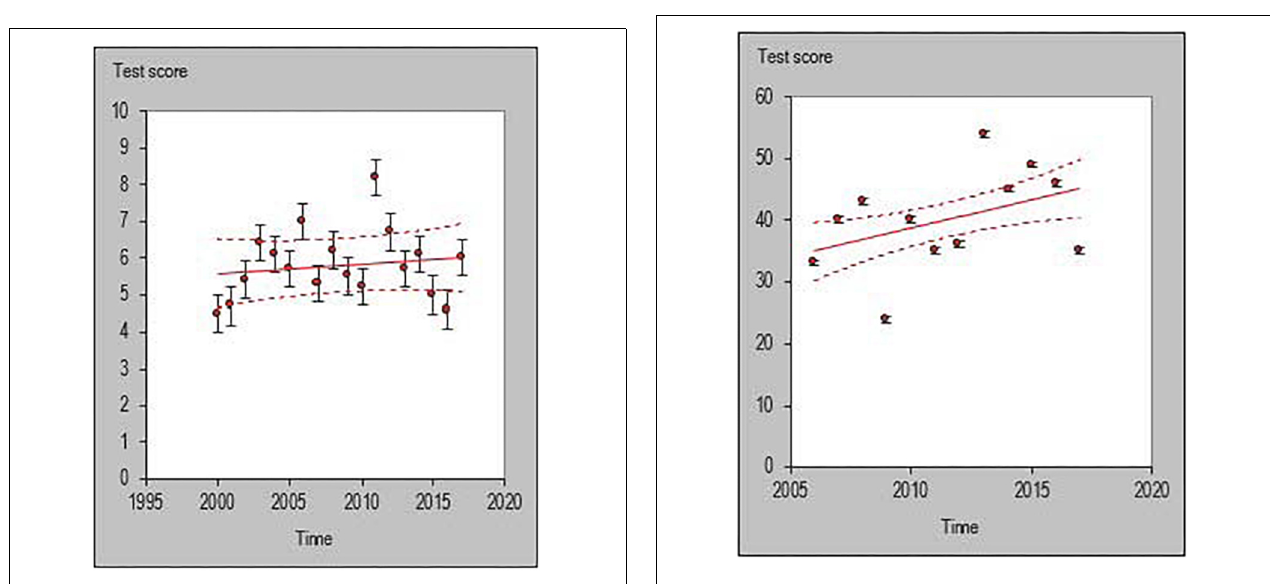
FIGURE 4 | Individual trend of one participant for 3-point percentage per